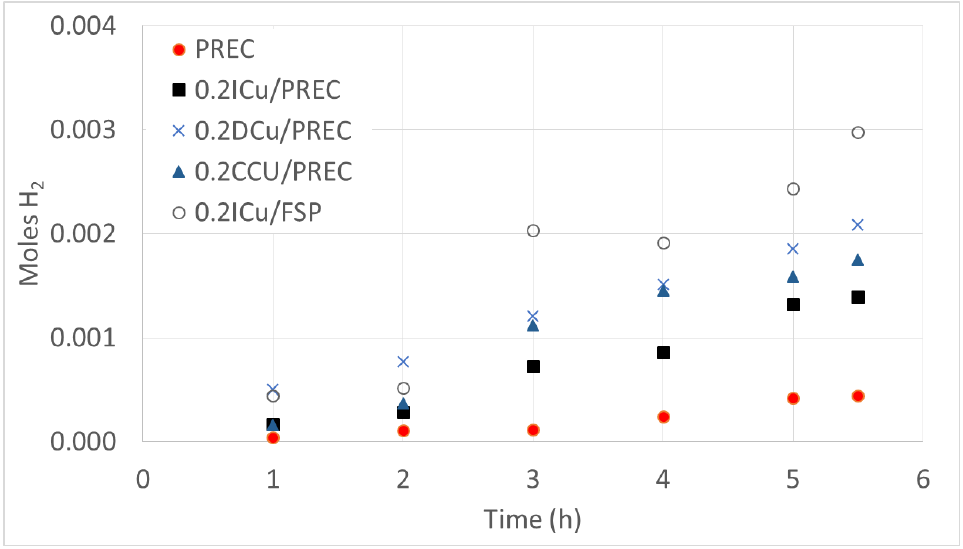
Figure 11. Cumulative hydrogen production (moles) comparison vs. time with 0.2 wt % CuO loaded on PREC and FSP by different methods (I, D and C).